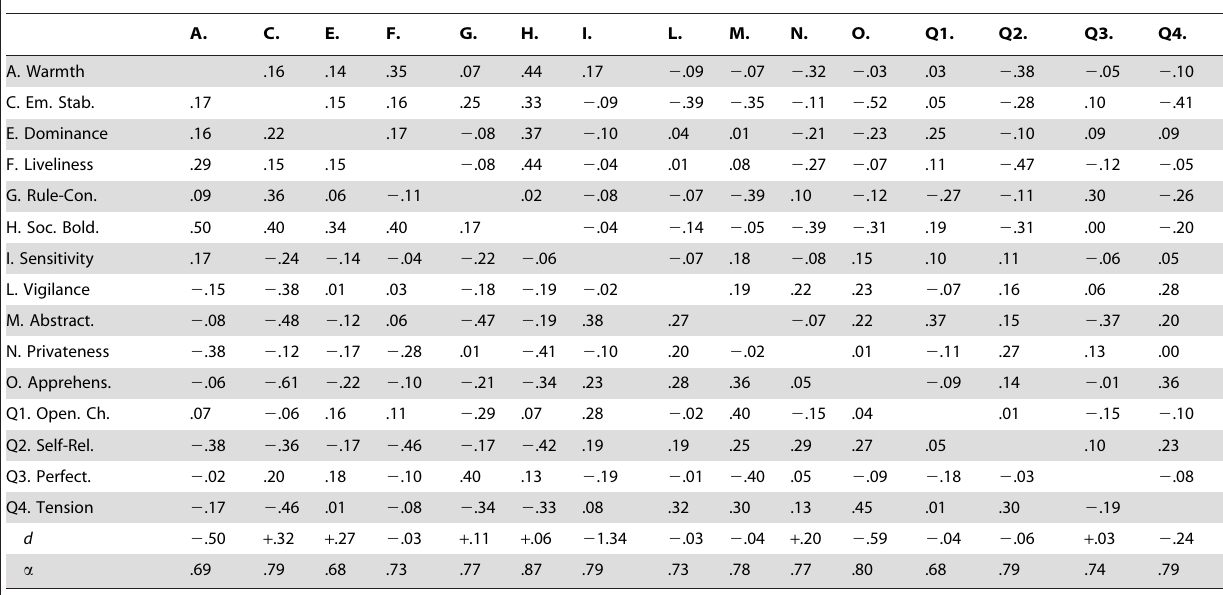
Table 1. Correlations and univariate effect sizes for observed